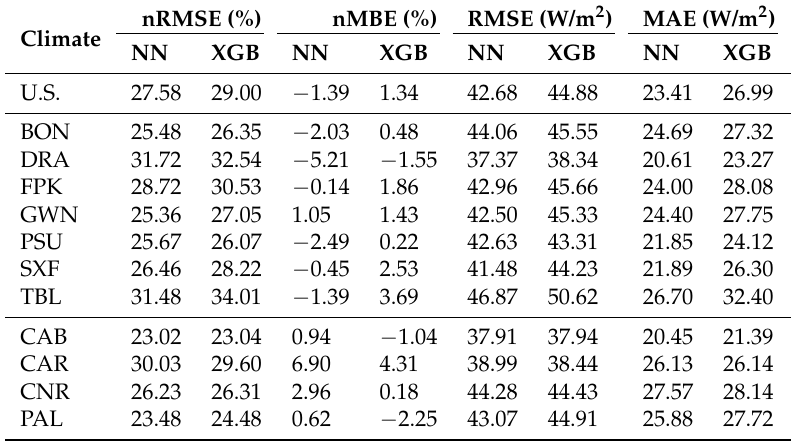
Table 10. The performance metrics of NN and XGB trained on 7 U.S. climates (2015 data). The results show the error in prediction of diffuse horizontal irradiance (2016 data) on U.S. and 4 unseen datasets of European